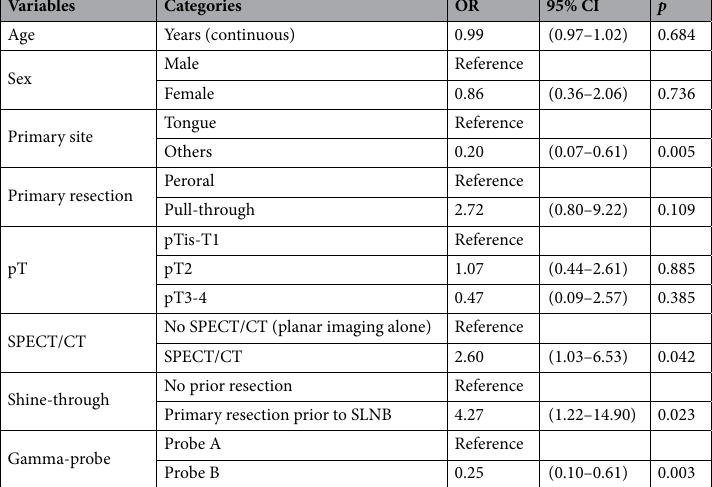
Table 3. Factors associated with the detection of a high number of SLNs. OR: odds ratio; CI: confidence interval; SLN: sentinel lymph node; SPECT/CT: single-photon emission computed tomography/computed